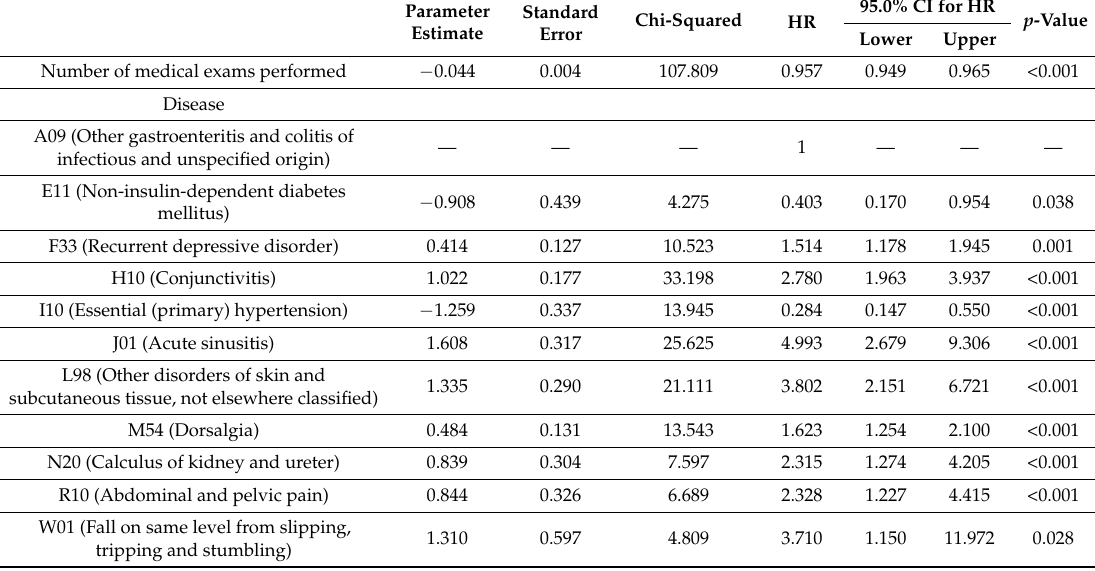
95.0% CI for HR Parameter Standard p -Value Chi-Squared HR Estimate Error Lower Upper